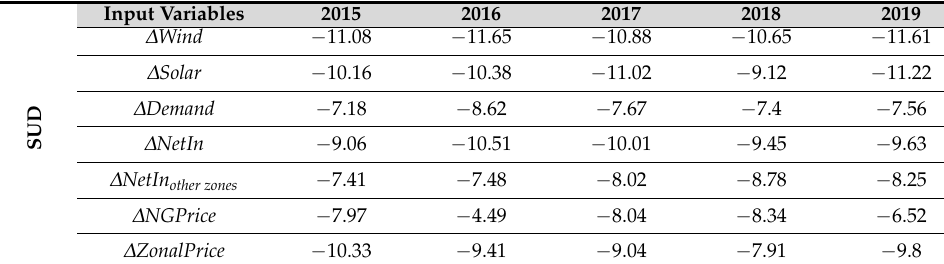
Table A6. Augmented Dickey–Fuller test statistics in 1st difference; SUD.